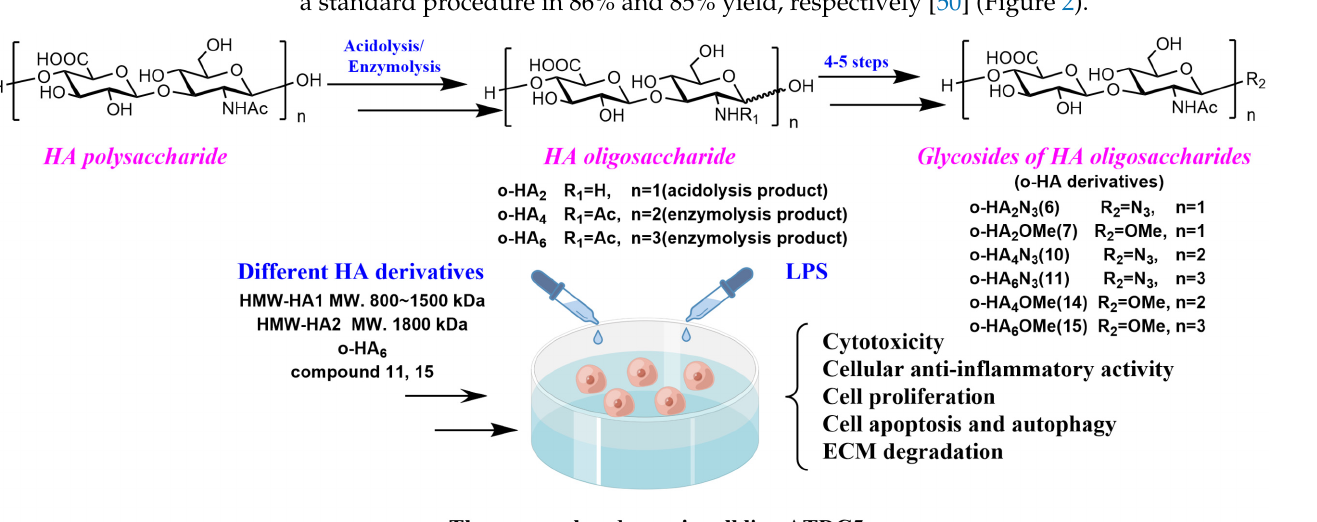
Figure 1. Synthesis of glycosides of HA oligosaccharides and evaluation of their biological activity in ATDC5 cells.